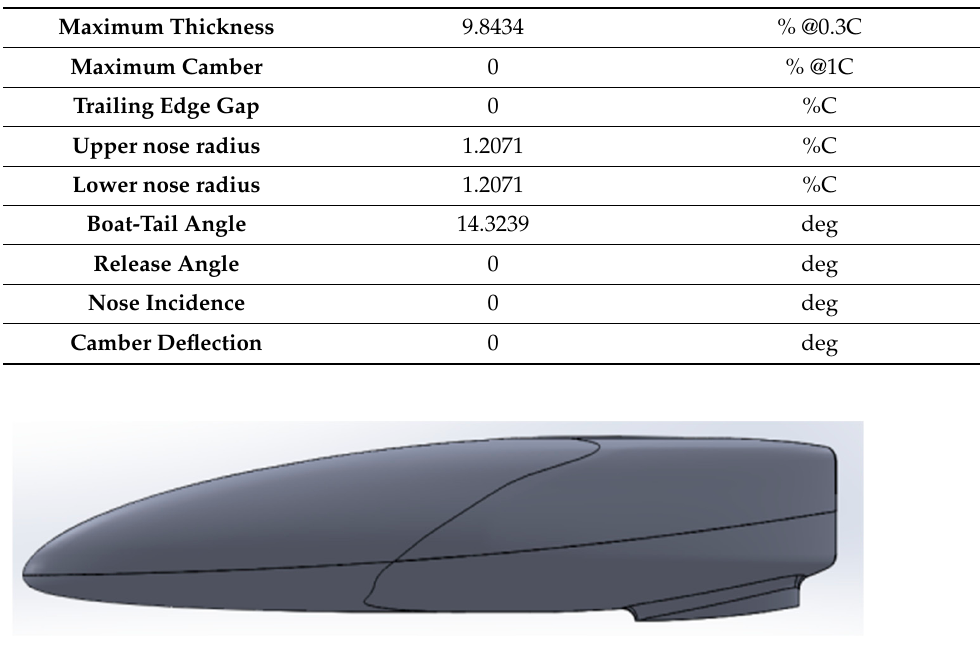
Figure 3. Car side view corresponding to Roncz Airfoil.